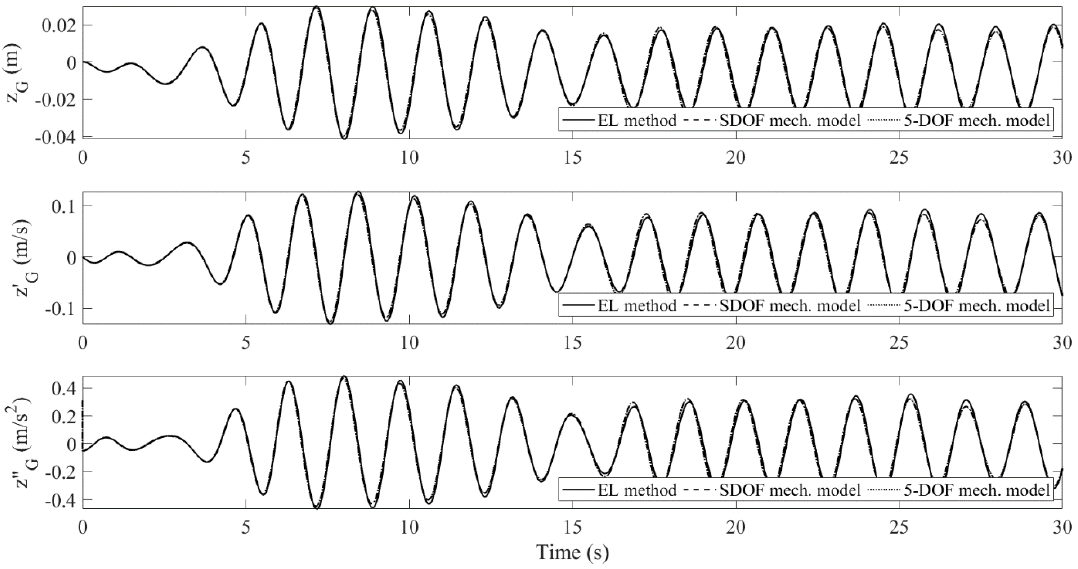
Figure 10. The heave motion responses of the floating body, configured with a water tank installed with porous media, undergoing large wave excitation.